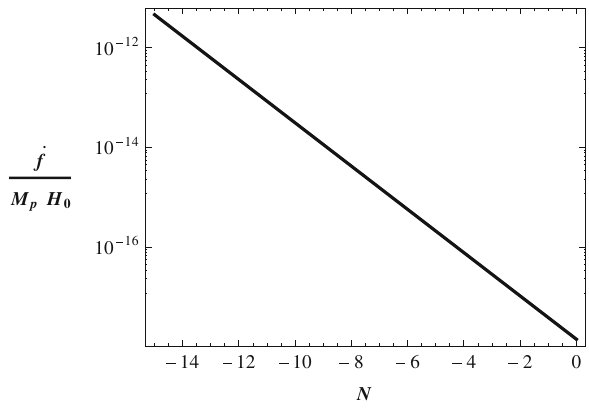
˙ f plotted against the number of M P H 0